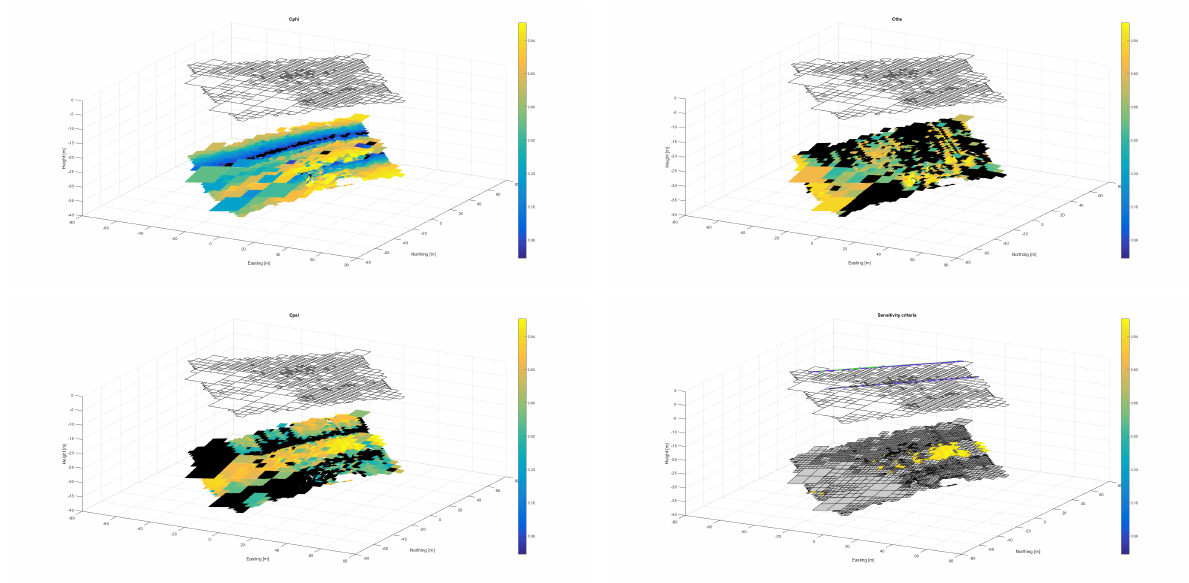
Figure 6. LIBAC data selection. Each cell represent the quad-tree planar surface element that was found in the overlaping area. Color code is its sensitivity criterion. The top grid is the result of the quad-tree. The color represents the angle sensitivity criteria. Above: left : roll ( C δϕ yaw C δψ , right : combination of all angles. Most sensitive surface elements to roll and yaw boresight p correspond to outer beams. Sensitive surface elements to pitch boresight are close to Nadir.